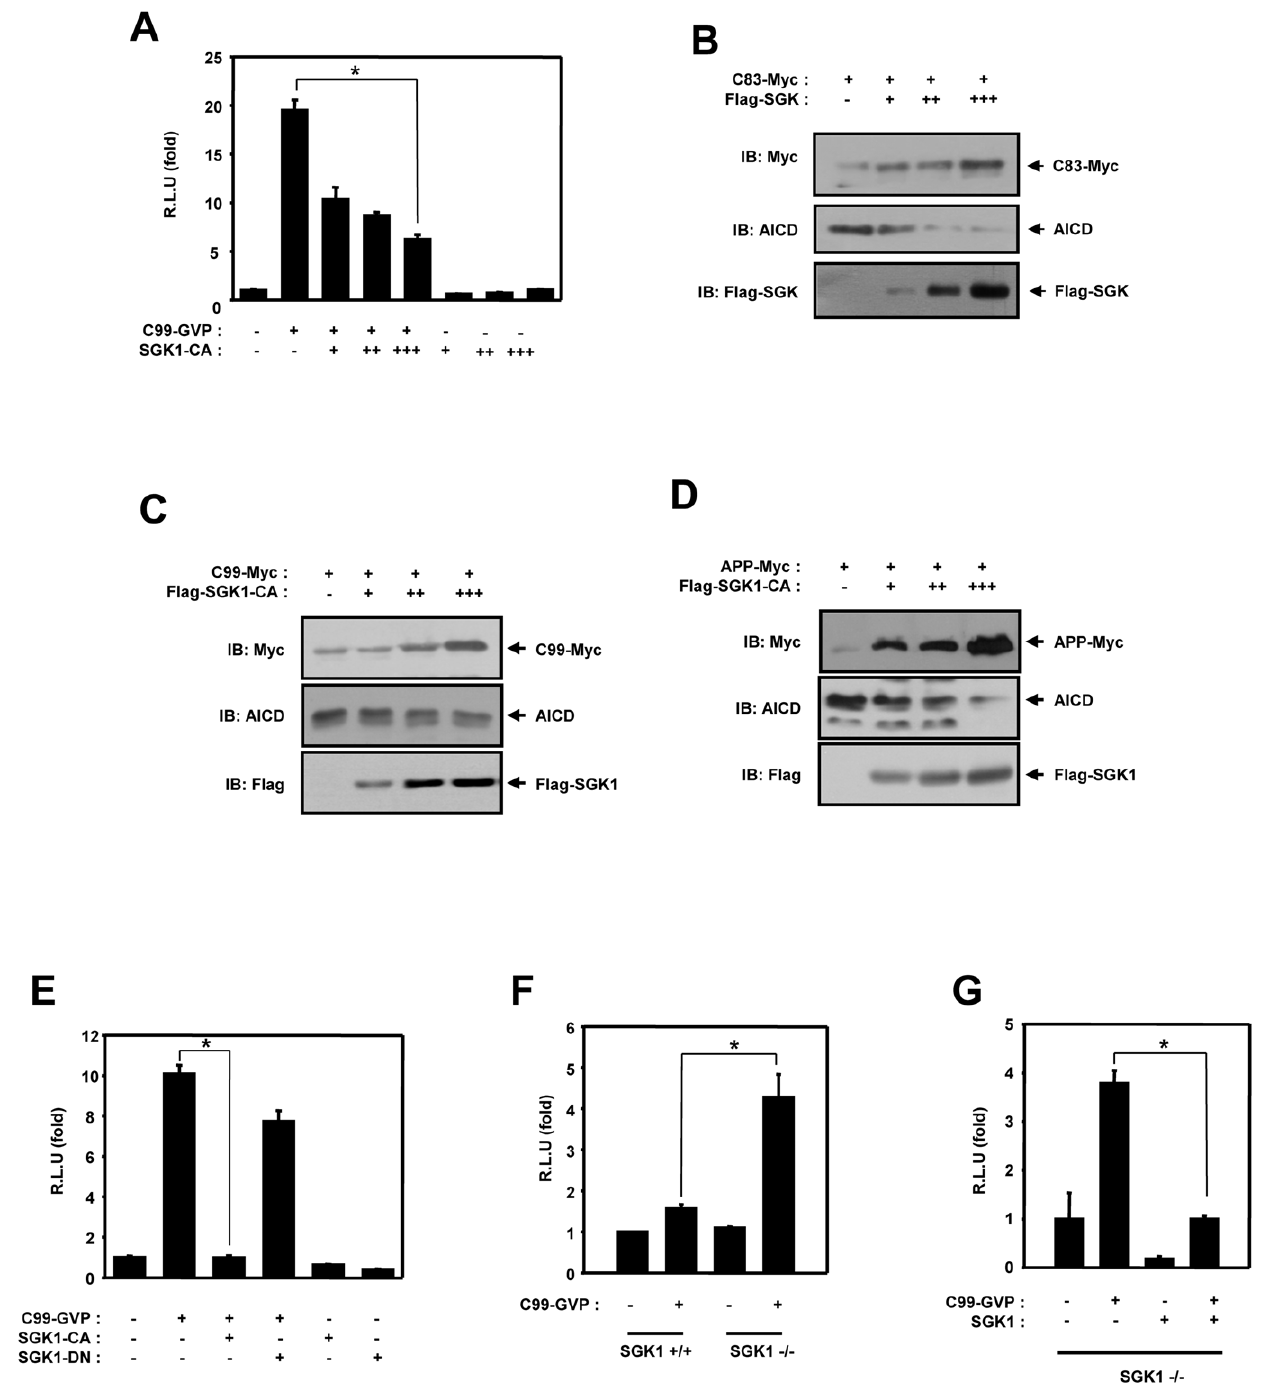
Figure 1. SGK1 downregulates gamma-secretase dependent APP cleavage. (A) HEK293 cells were transfected with expression vectors encoding for 100 ng of GAL4-Luc, 100 ng of beta-galactosidase, along with 200 ng of C99-Gal4/VP16 and 200 ng( + ), 400 ng( ++ ) and 600 ng( +++ ) of SGK1-CA, as indicated. (B) HEK293 cells were transfected for 48 hours with expression vectors encoding for 500 ng of C99-Myc, along with 500 ng ( + ), 1 m g ( ++ ) and 1.5 m g ( +++ ) of Flag-SGK1 CA, as indicated. (C) HEK293 cells were transfected for 48 hours with expression vectors encoding for 500 ng of C99-Myc, along with 500 ng ( + ), 1 m g ( ++ ) and 1.5 m g ( +++ ) of Flag-SGK1 CA, as indicated. (D) HEK293 cells were transfected for 48 hours with expression vectors encoding for 500 ng of APP695, along with 500 ng ( + ), 1 m g ( ++ ) and 1.5 m g ( +++ ) of Flag-SGK-CA. (B, C, D) The cell lysates were immunoblotted with anti-Myc (9E10), anti-APP c-terminal and anti-Flag antibodies (E) HEK293 cells were transfected with expression vectors encoding for 200 ng of C99-Gal4/VP16, 100 ng of GAL4-Luc, 100 ng of beta-galactosidase, 600 ng of SGK1-CA and SGK1-DN. (F) MEF cells from SGK1 + / + and SGK1 2 / 2 mice were transfected with expression vectors encoding for 200 ng of C99-Gal4/VP16 and 100 ng of beta-galactosidase with GAL4-Luc (G) MEF cells from SGK1 2 / 2 mice were transfected with expression vectors encoding for 100 ng of GAL4-Luc, 100 ng of beta-galactosidase and 200 ng of HA-SGK1 with 100 ng of C99-Gal4/VP16. (A, E–G) After 48 hours of transfection, the cells were lysed and the luciferase activity was assayed. Data were normalized to beta-galactosidase activity. The results are expressed as the means 6 SEM from three independent experiments.